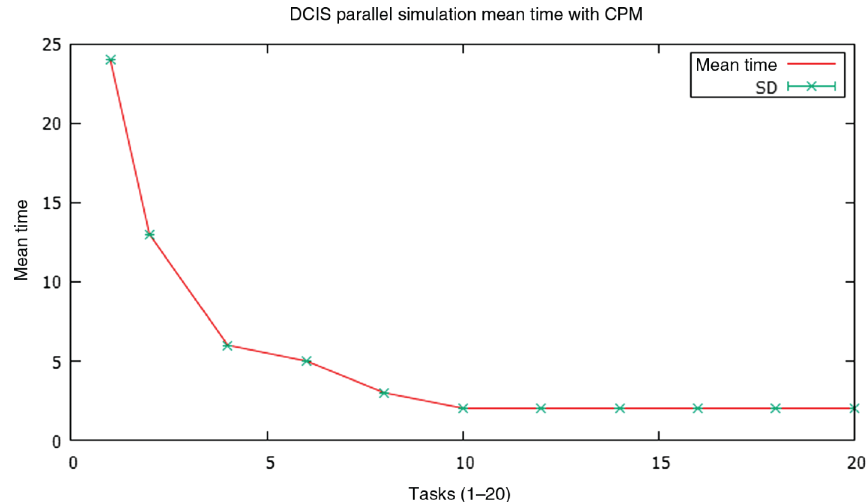
Figure 8: Average times for an increasing number of parallel threads, obtained by averaging the times resulting from run- ning the simulation with the same initial conditions in eight different nodes of the